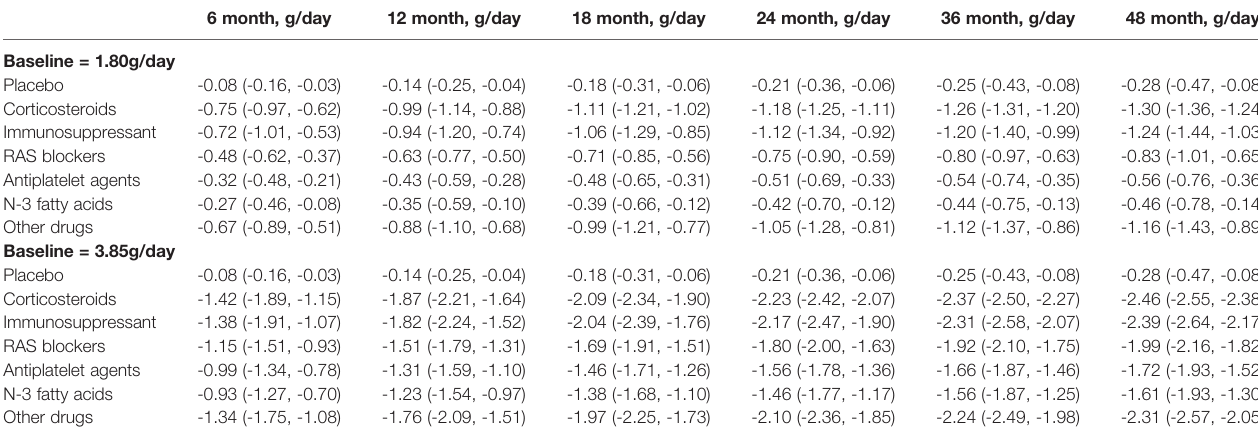
TABLE 3 | Distribution of typical values for placebo and each drug effect at baseline urine protein of 1.80g/day and 3.85g/day (median, 95%Cl).